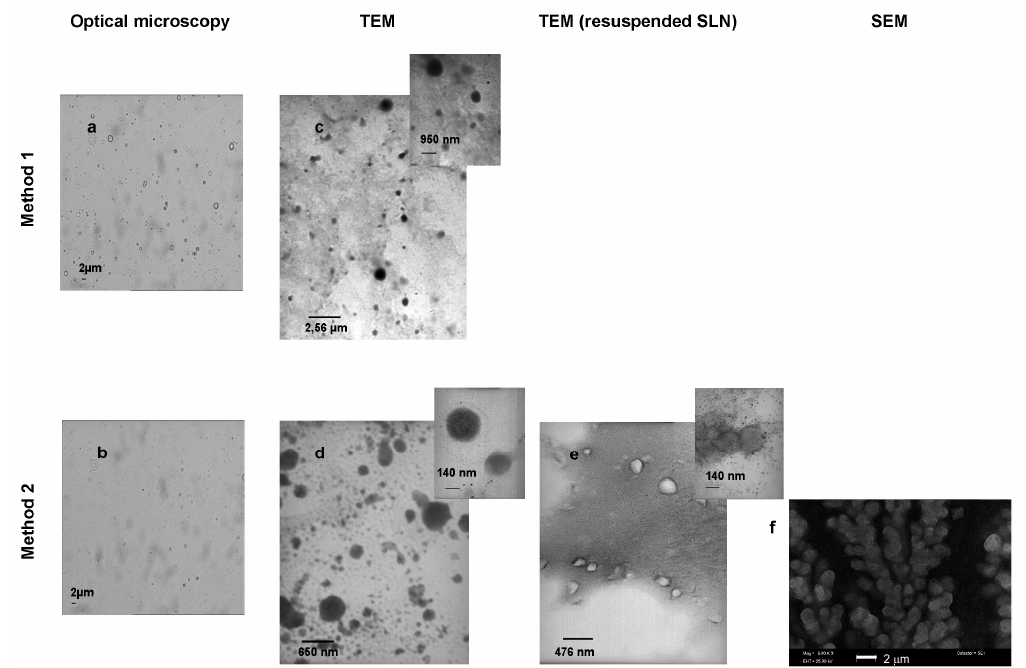
Figure 2. Microscopy of blank SLN. ( a ) optical microscopy of SLN obtained by method 1; ( b ) optical microscopy of SLN obtained by method 2; ( c ) TEM of SLN obtained by method 1; ( d ) TEM of SLN obtained by method 2; ( e ) TEM of SLN, centrifuged and resuspended, obtained by method 2; ( f ) SEM of SLN obtained by method 2.